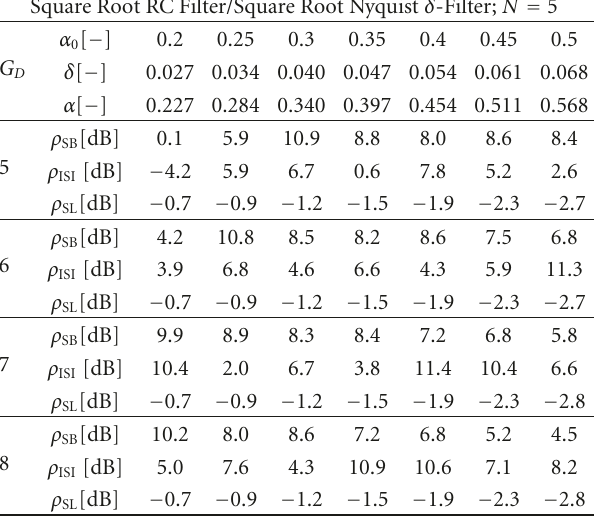
Table 1: Numerical values of ρ SB [dB], ρ ISI [dB], ρ SL [dB]. Square root RC filter versus square root Nyquist δ -filter. The oversampling factor N = 5 is fixed and the group delay parameter G D and roll-o ff parameter α of the filters vary.